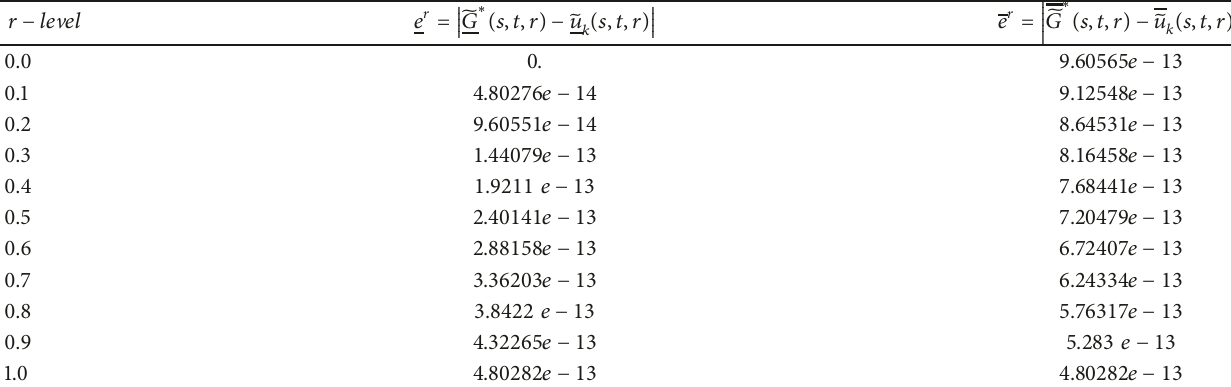
Table 3: The absolute errors on the level sets with 𝑛 = 2 , 𝑘 = 5 for Example 14 by using the proposed method in (𝑠,𝑡) = (0.5,0.5) . 𝑟 − 𝑙𝑒 V 𝑒𝑙